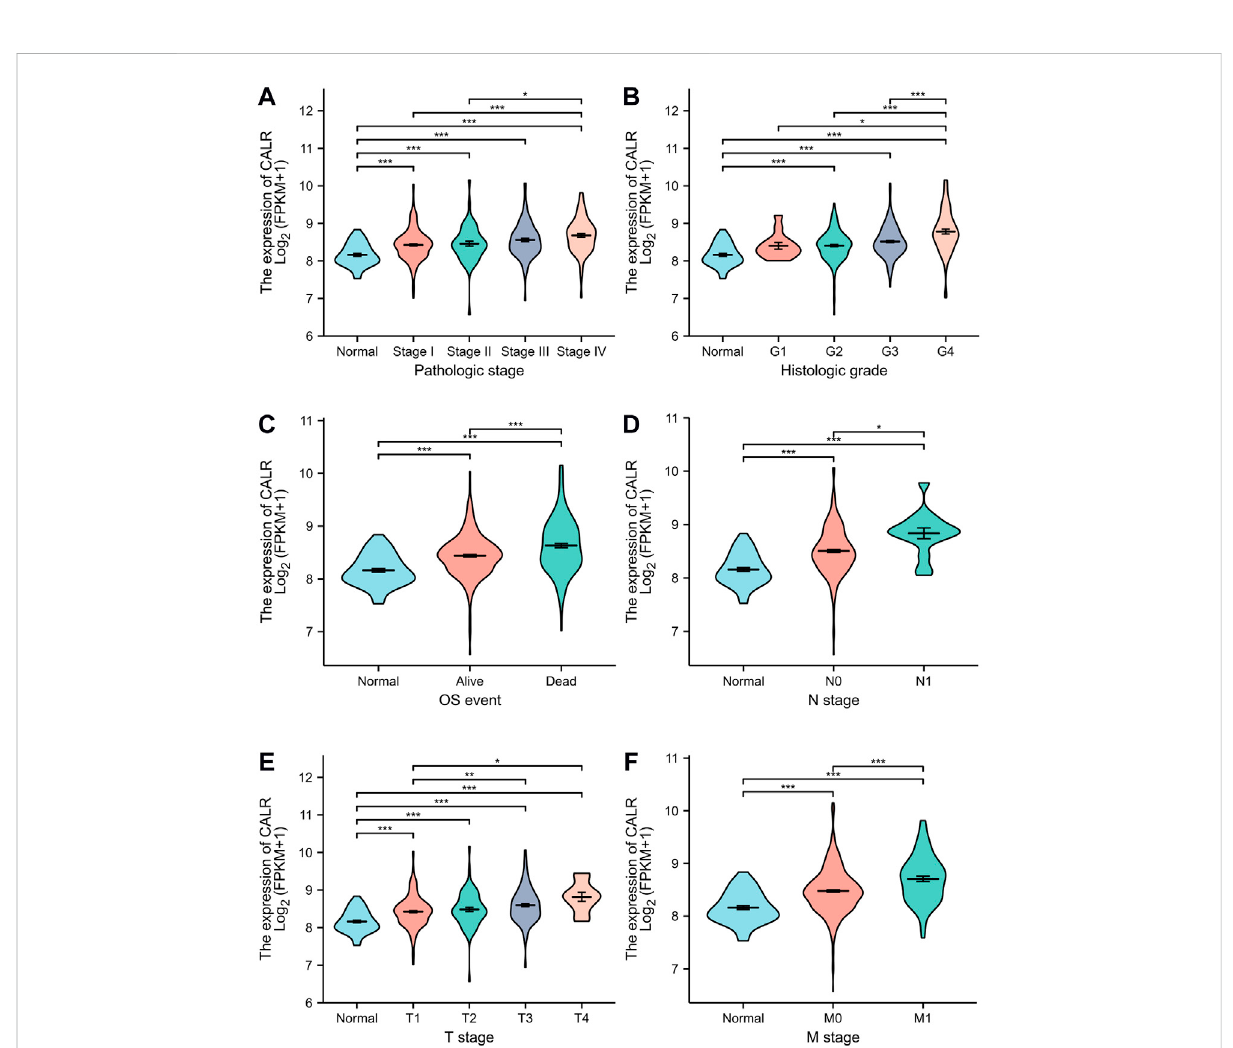
FIGURE 4 Violin plot evaluating CALR expression of patients with KIRC according to different clinical characteristics. (A) Pathologic stage; (B) histologic grade; (C) OS event; (D) N stage; (E) T stage; and (F) M stage (* p < 0.05, ** p < 0.01, *** p < 0.001).